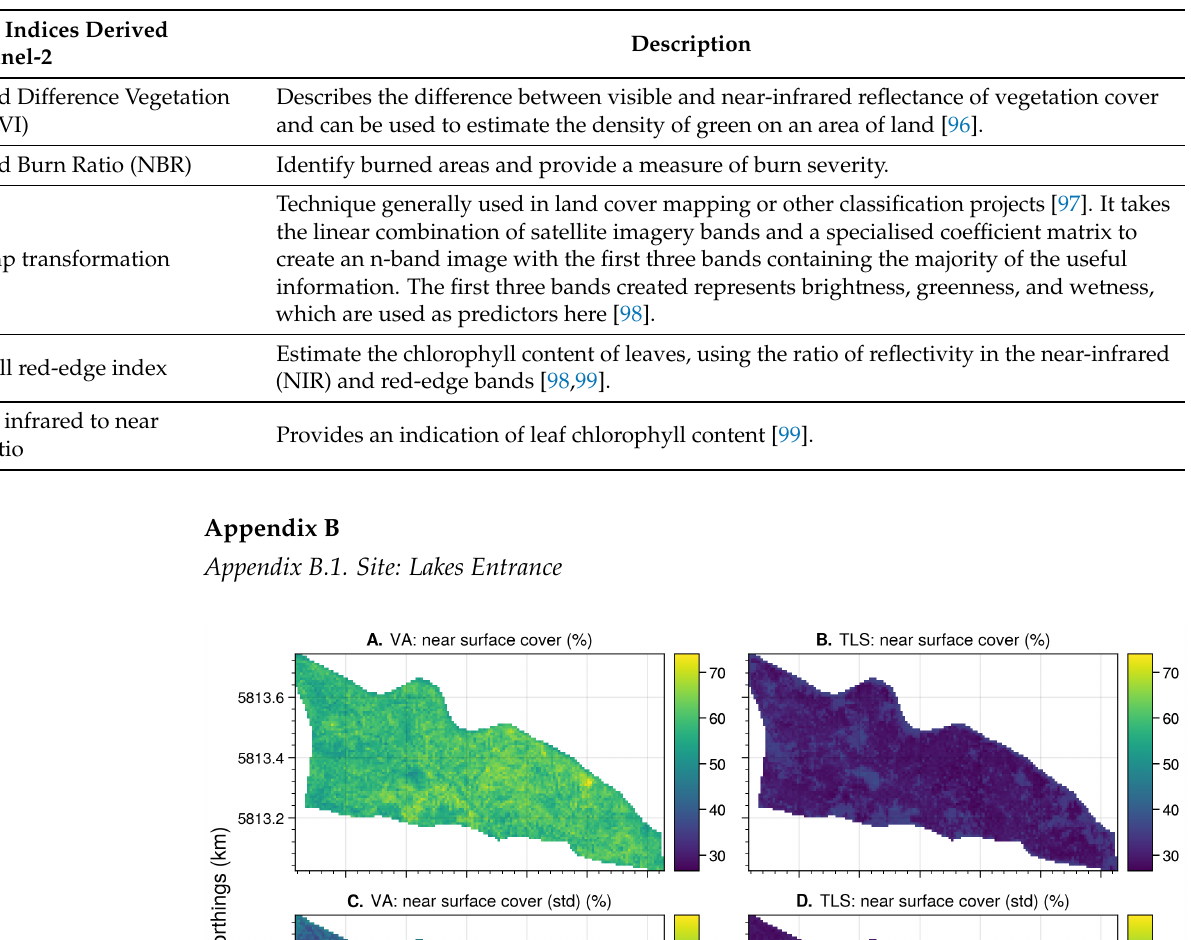
Table A4. Vegetative indices derived from bands obtained from Sentinel-2 multi-spectral imagery for each site.